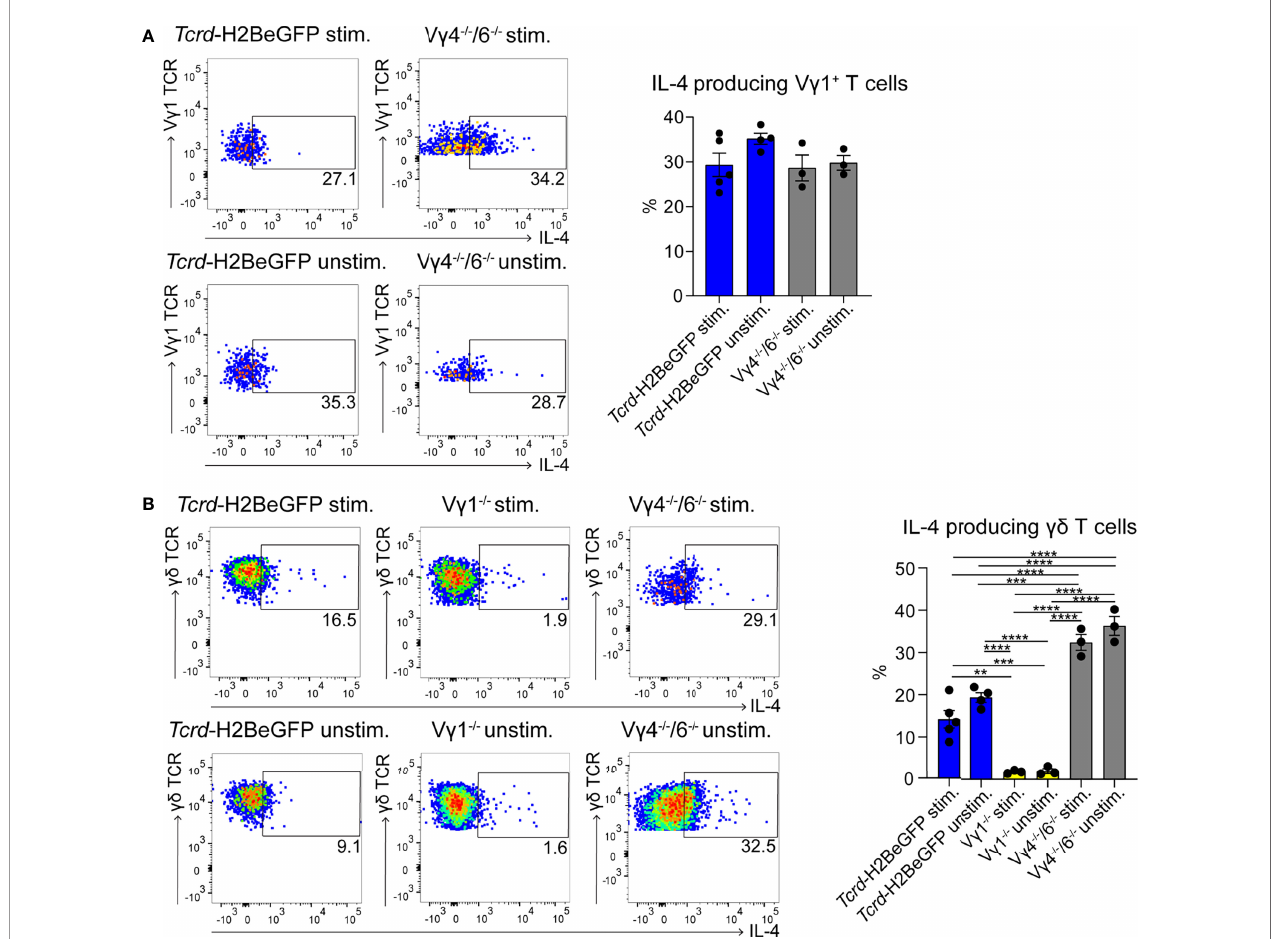
FIGURE 2 | gd T cells represent a major source of IL-4 in PPs. (A, B) IL-4 + gd T cells were measured by fl ow cytometry with an IL-4 secretion assay. PPs from Tcrd -H2BeGFP, V g 1 − / − , and V g 4 − / − /V g 6 − / − mice were stimulated with mAbs directed against CD3 (1 µg/ml) and CD28 (1 µg/ml) for 2 h and compared to the unstimulated controls. (A) FACS analysis of IL-4 + V g 1 + T cells in PPs of Tcrd -H2BeGFP and V g 4 − / − /V g 6 − / − mice gated on V g 1 + T cells (CD19 − , TCR b − , CD3 + , GFP + , V g 1 TCR + ). Bar graph, mean ± SEM. n = 3 – 5 per group. ANOVA test was applied with Tukey post-hoc test. (B) FACS analysis of IL-4 + gd T cells of PPs from Tcrd - H2BeGFP, V g 1 − / − , and V g 4 − / − /V g 6 − / − mice gated on gd T cells (CD19 − , TCR b − , CD3 + , GFP + ). Bar graph, mean ± SEM. n = 3 – 5 per group. ANOVA test was applied with Tukey post-hoc test. Each dot represents an individual mouse. **P < 0.01, ***P < 0.001, ****P<